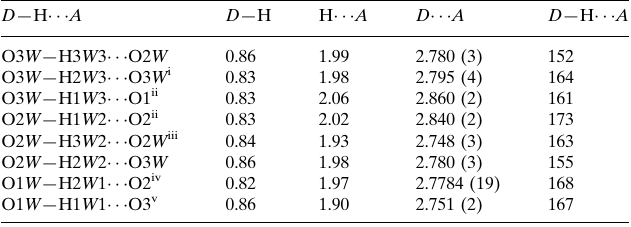
Bruker SMART CCD area-detector diffractometer Absorption correction: multi-scan ( SADABS ; Sheldrick, 1996) T min = 0.645, T max = 0.840